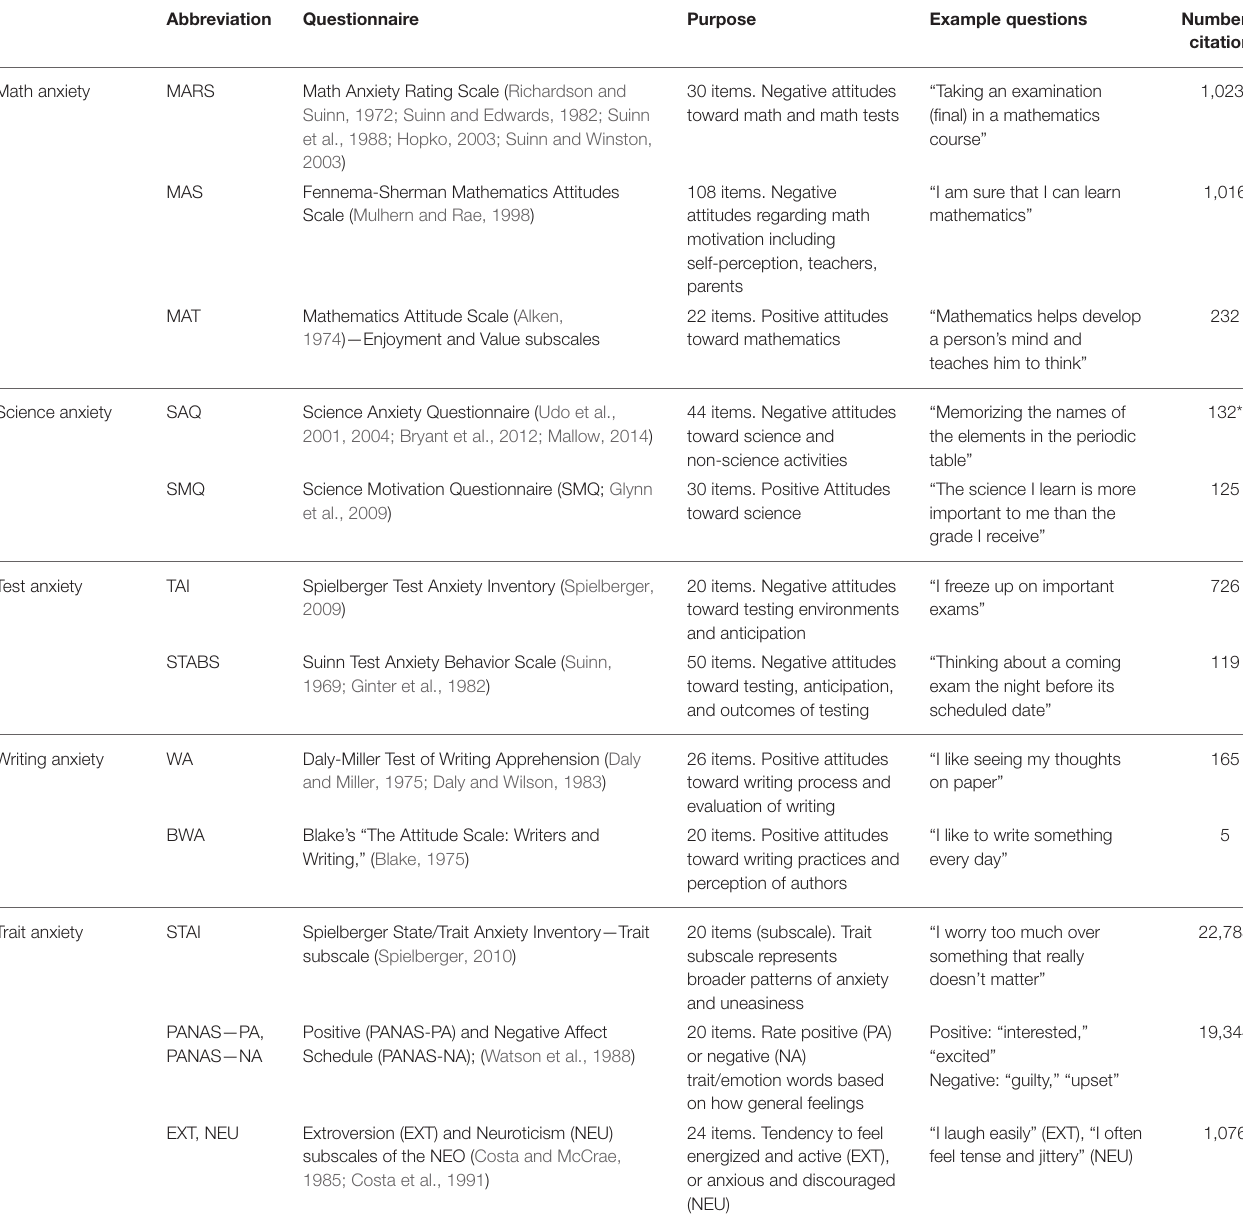
TABLE 1 | Questionnaires selected in Study 1 to represent multiple domains of anxiety: math, science, writing, test, and trait